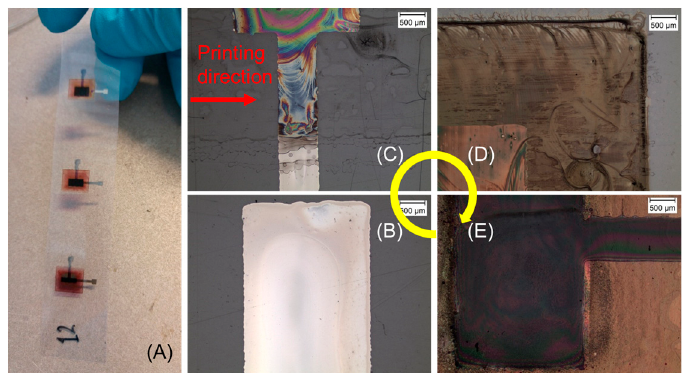
Figure 4. ( A ) Photo of all inkjet-printed OPVs of different active areas and microscopic images of the printed functional layer corresponding to ( B ) the bottom Ag cathode electrode, ( C ) the ZnO ETL layer, ( D ) the P3HT:PCBM bulk heterojunction or photoactive layer, and ( E ) the top PEDOT:PSS anode electrode layer, shown exemplarily for 2.5 mm × 5 mm.